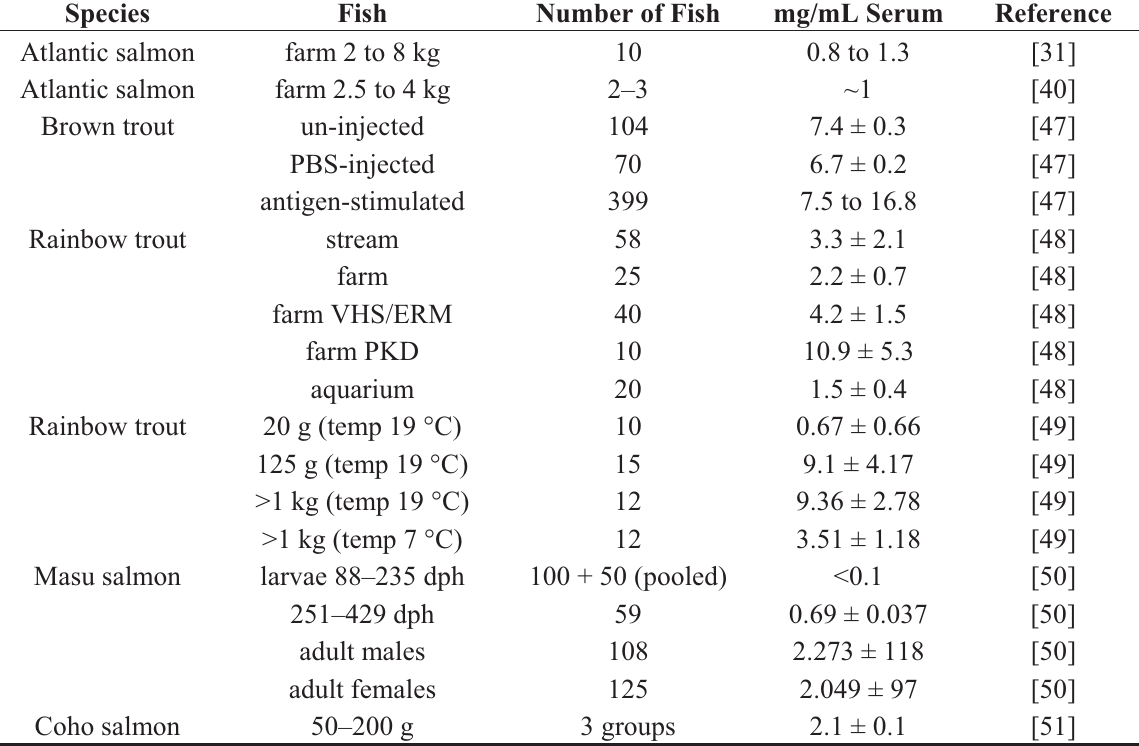
Table 1. IgM concentration in serum of salmonid fish.